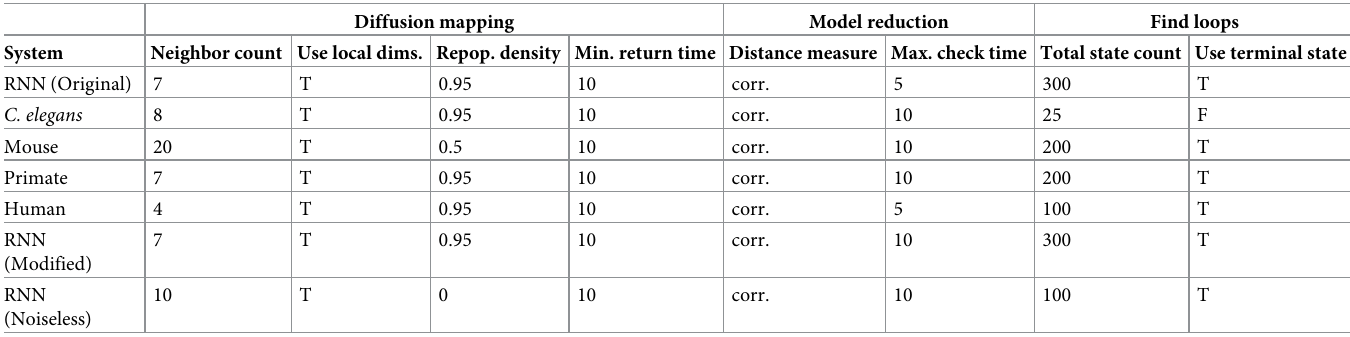
Fig E in S1 Text). Thus, simple LOOPER models can successfully predict complex neuronal signals recorded at different scales and across distinct biological and artificial systems. LOOPER falls into a general modeling methodology called the Hidden Markov Models (HMMs), but differs significantly from conventional HMM implementations in the way the transition probability matrix is constructed and then simplified. Standard HMM algorithms find the set of states and transition probability matrix under which the observed data is most probable. In contrast, LOOPER follows a topological data analysis approach to build up a model of the dynamics based on local transition probabilities and the assumption that trajecto- ries are stable. To examine how the modifications used by LOOPER affect both quantitative performance and interpretability of the model, we compared LOOPER to conventional HMM trained using the Expectation-maximization [42] algorithm implemented in the Bayes Net Toolbox [43]. Each dataset was preprocessed using the same state space discovery method as used for the LOOPER model and after applying standard symmetric diffusion mapping (S1 Text). Bayesian optimization was used to identify optimal hyper-parameters. We find that LOOPER and HMM are both able to reconstruct and model the data with comparable accu- racy (Fig 5J–5M, left). However, LOOPER drastically outperforms HMM on decoding the task condition from the model state (Fig 5J–5M, right). Thus, the higher interpretability of LOOPER models does not come at the expense of high quantitative accuracy and the ability to predict future neuronal activity. Table 2. Parameters used in LOOPER